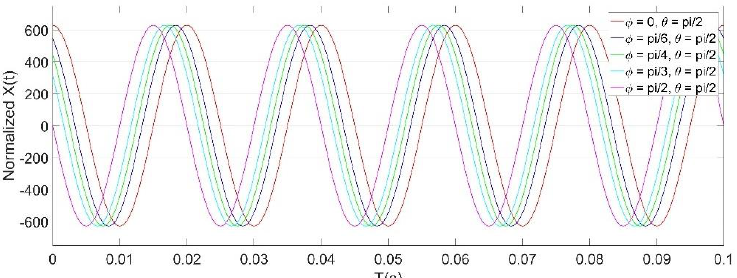
The simulation results show that X ( t ) is a sine wave with a frequency of 50 Hz.